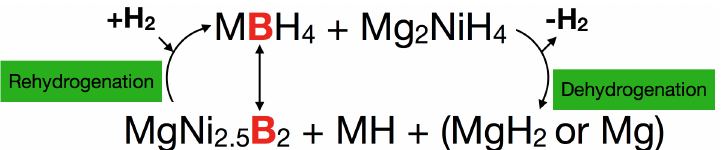
Figure 11. Schematic representation of the function of the Mg 2 NiH 4 boron carrier in the metal borohydride (MBH 4 ) hydrogenation cycle, shown without consideration of reaction